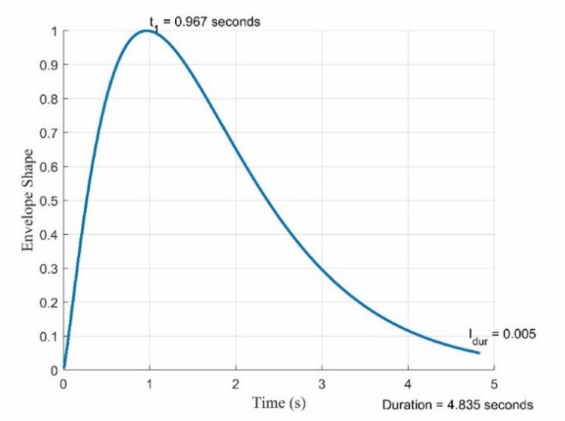
Figure A3. The shape curve for an M6 R30 km earthquake event. The acceleration response spectrum and the power spectral density function (PSDF) of the ground motion need to be pre-defined at the beginning of the iteration process. In each iteration, the acceleration response spectrum is compared to the target spectrum for assessing the relative errors. When the magnitude of the relative errors exceeds the tolerable limit, the calculated PSDF is modified by the square of the ratio of the targeted and calculated response spectral